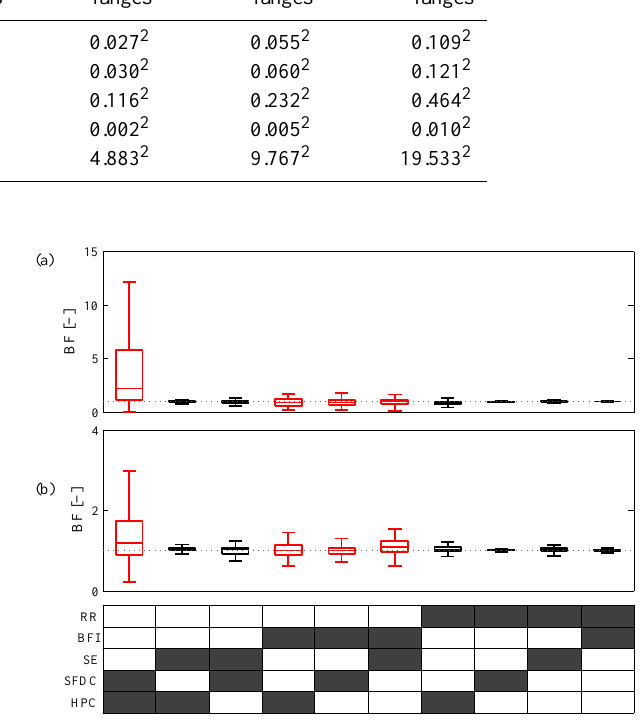
Figure 2. The Bayes factor for the 10 pairs of signatures over the 84 catchments when the observation-based error structure is used with (a) observed streamflow data, (b) synthetic streamflow data. The upper whisker represents the upper quartile plus 1.5 times the in- terquartile range and the lower whisker represents the lower quartile minus 1.5 times the interquartile range. The dashed line represents BF =